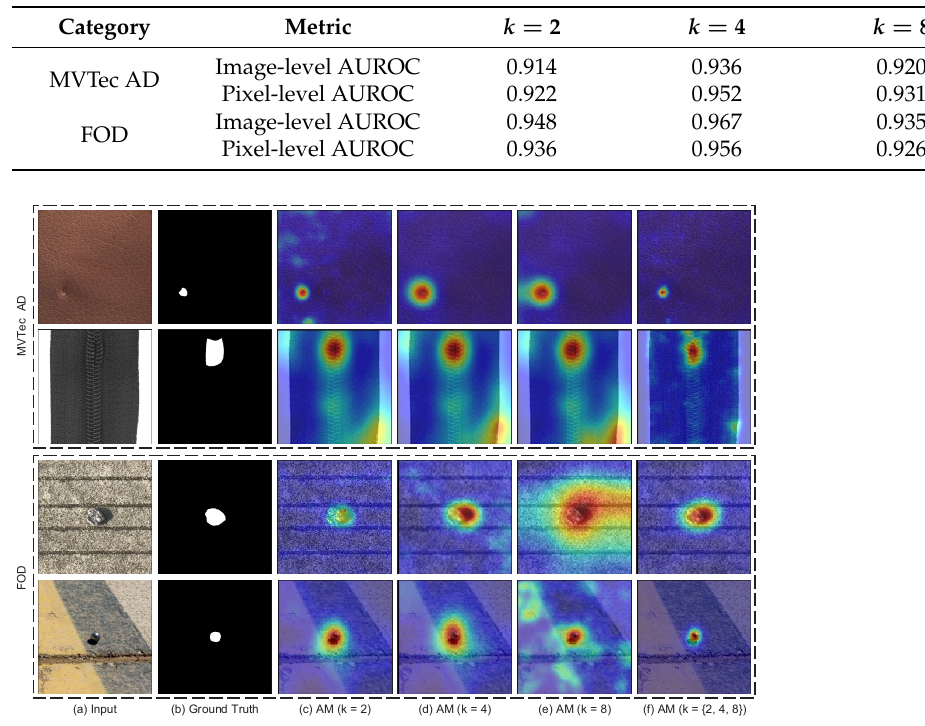
Table 7. The results of MSFI trained and evaluated using a single gird size on the MVTec AD and FOD datasets.